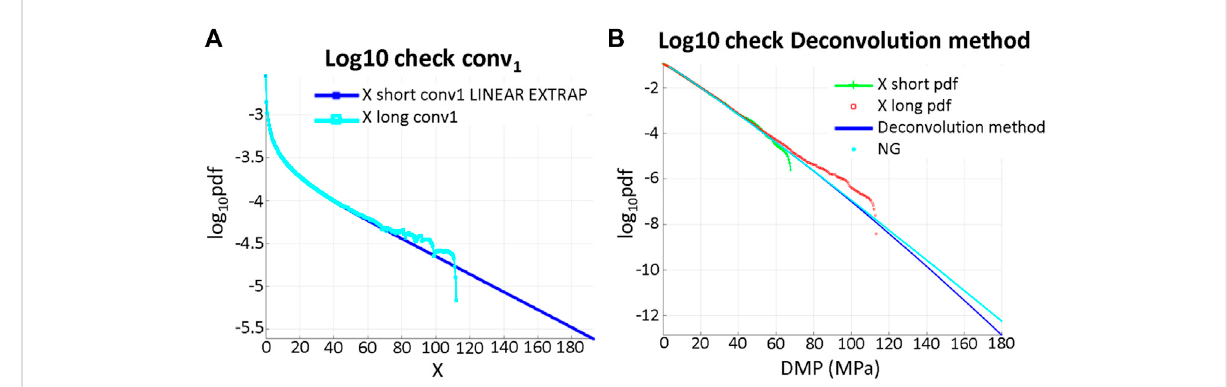
FIGURE 7 DMP stress. (A) Scaled f X 1 tail on a decimal log scale for the «shorter» data (cyan), linearly extrapolated (dark blue). (B) Unscaled raw «shorter» data (green) f X tail on a decimal log scale, extrapolated by deconvolution method (dark blue), along with «longer» raw data (red) and NG extrapolation